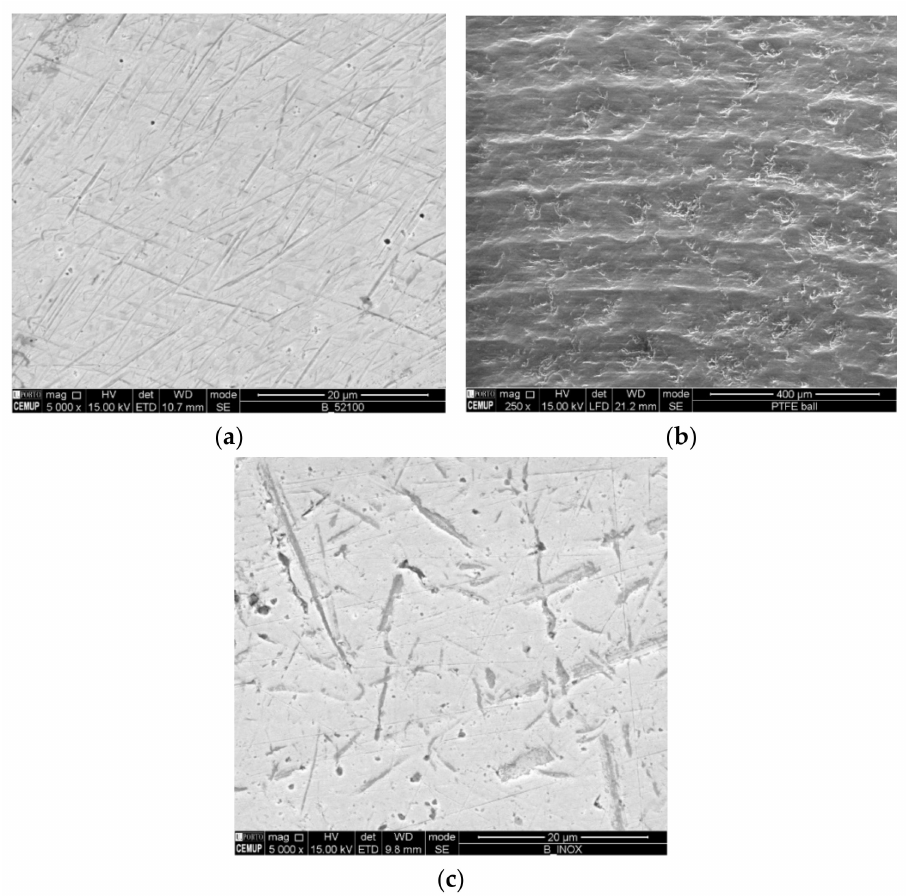
Figure 1. Balls’ morphology before testing: ( a ) AISI 52100 steel balls polished state; ( b ) Teflon PTFE balls; ( c ) SS AISI 304 steel balls polished